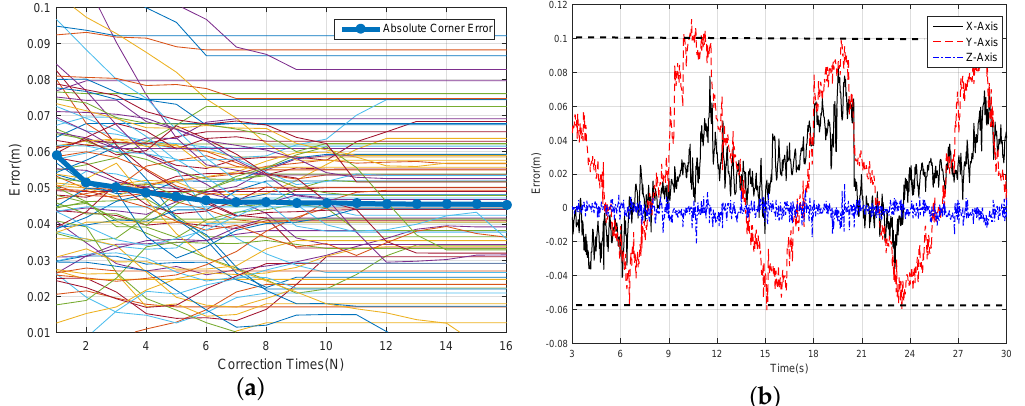
Figure 8. Mapping Error of Experiment Site. ( a ) Mapping Error; ( b ) Positioning